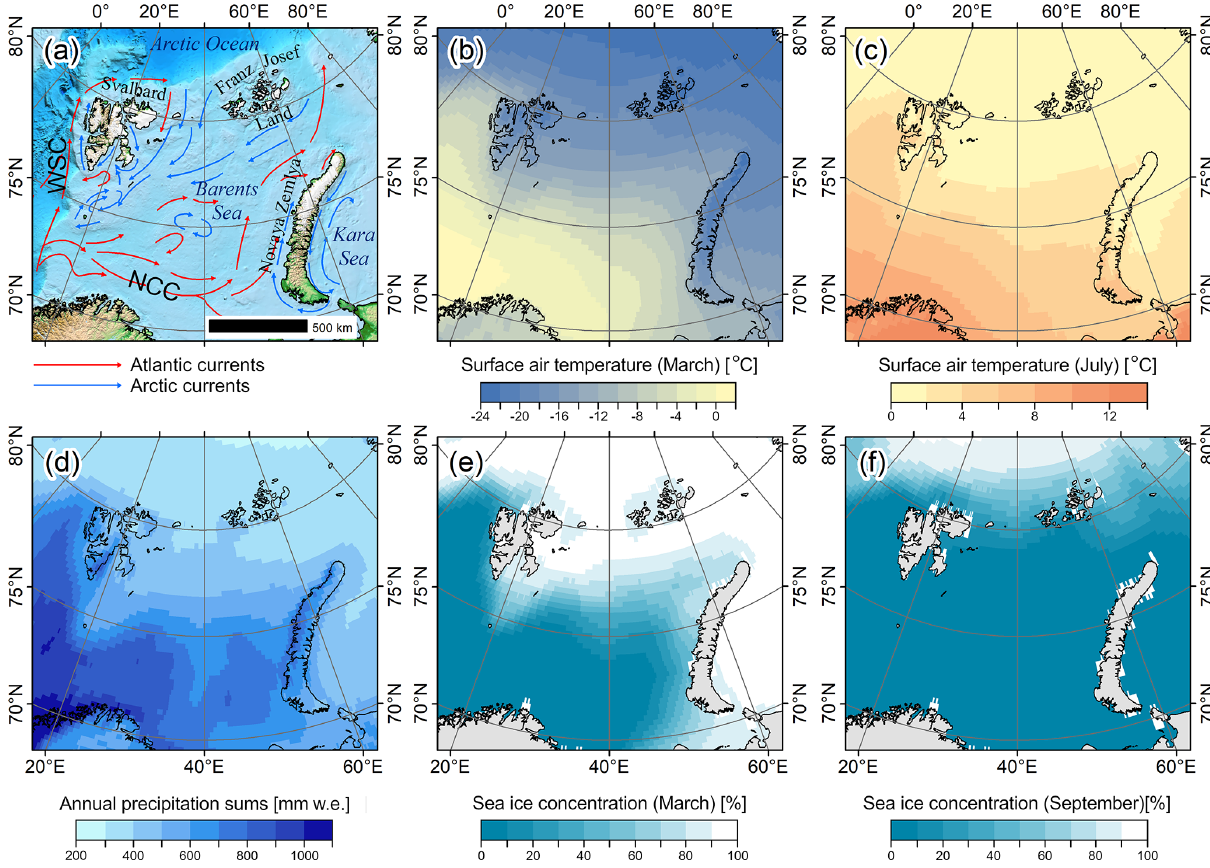
Figure 1. (a) Topography of the Barents Sea area and transport of Atlantic water (red arrows) and Arctic water (blue arrows) based on the Institute of Marine Research in Bergen, Norway. WSC: West Spitsbergen Current; NCC: North Cape Current. (b–f) ERA5 1981–2010 climatology for the Barents Sea area ( b – March near-surface air temperature, c – July near-surface air temperature, d – annual precipitation sums, e – sea ice concentration in March, f – sea ice concentration in